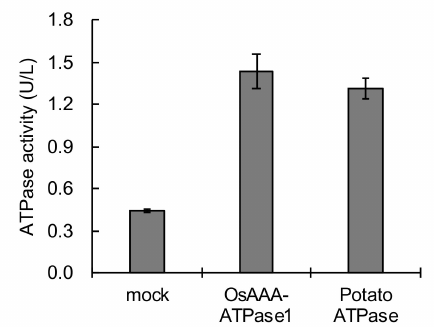
Figure 6. ATPase activity of recombinant OsAAA-ATPase1 protein. Elution bu ff er of Ni-resin (mock treatment), and an ATPase protein from potatoes, were used negative and positive controls,